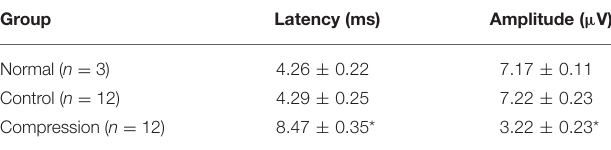
TABLE 1 | Average amplitude and latency of the three groups (* P <